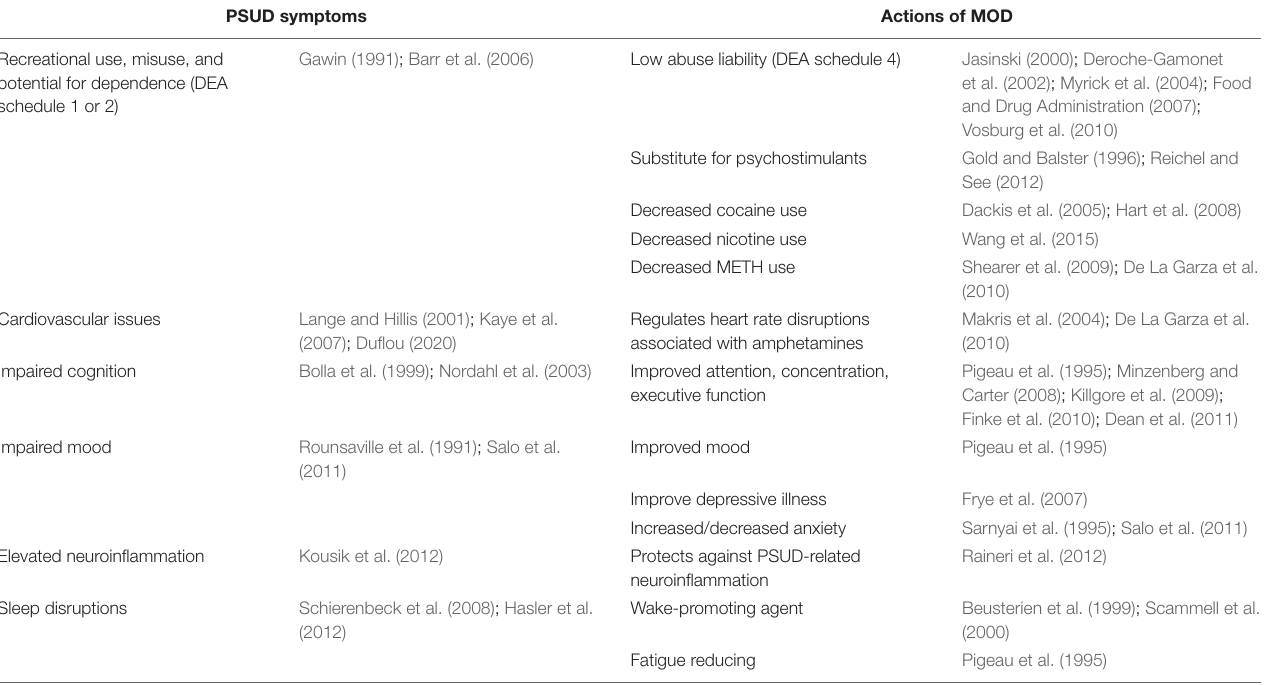
TABLE 1 | Symptoms related to PSUD and potential therapeutic actions of